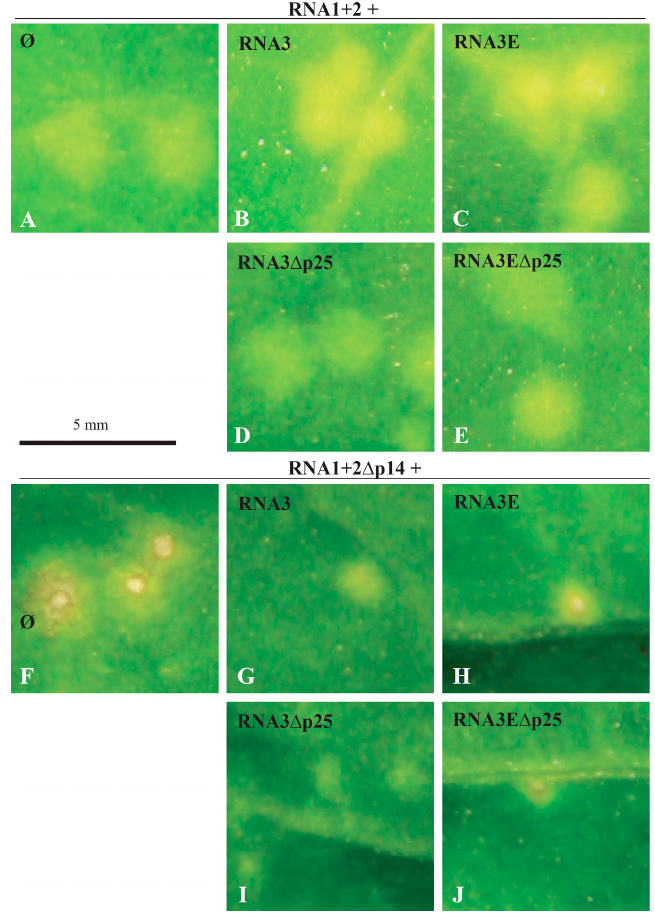
Figure 1. Beet necrotic yellow vein virus (BNYVV) noncoding RNA3 (ncRNA3) complements the absence of the p14 viral suppressor of RNA silencing (VSR) protein independently of expression of the RNA3-encoded p25 protein. The presence of ncRNA3-producing RNA species alleviates the necrosis obtained in the absence of p14. A close-up of Chenopodium quinoa local lesions at seven days post-infection (dpi) with genomic RNA1 + 2 ( A – E ) or RNA1 + 2 ∆ p14 (deletion of the VSR) ( F – J ), in the presence of RNA3 species able to accumulate ncRNA3 (panels B , D , G , and I ) or in the presence of RNA3E species unable to accumulate ncRNA3 (panels C , E , H , and J ).